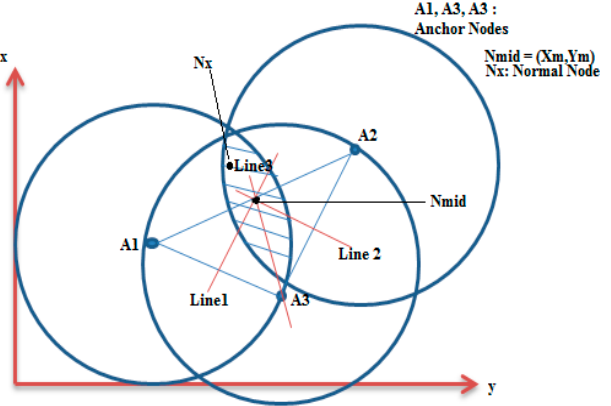
Figure 4. Mid-perpendicular using a right triangle. Similarly, the midpoint ( Nmid ) of the longest side ( A1 to A2 ) of the triangle would again be the unknowing node’s coordinates, as represented in Figure 5 [55] for an obtuse triangle.